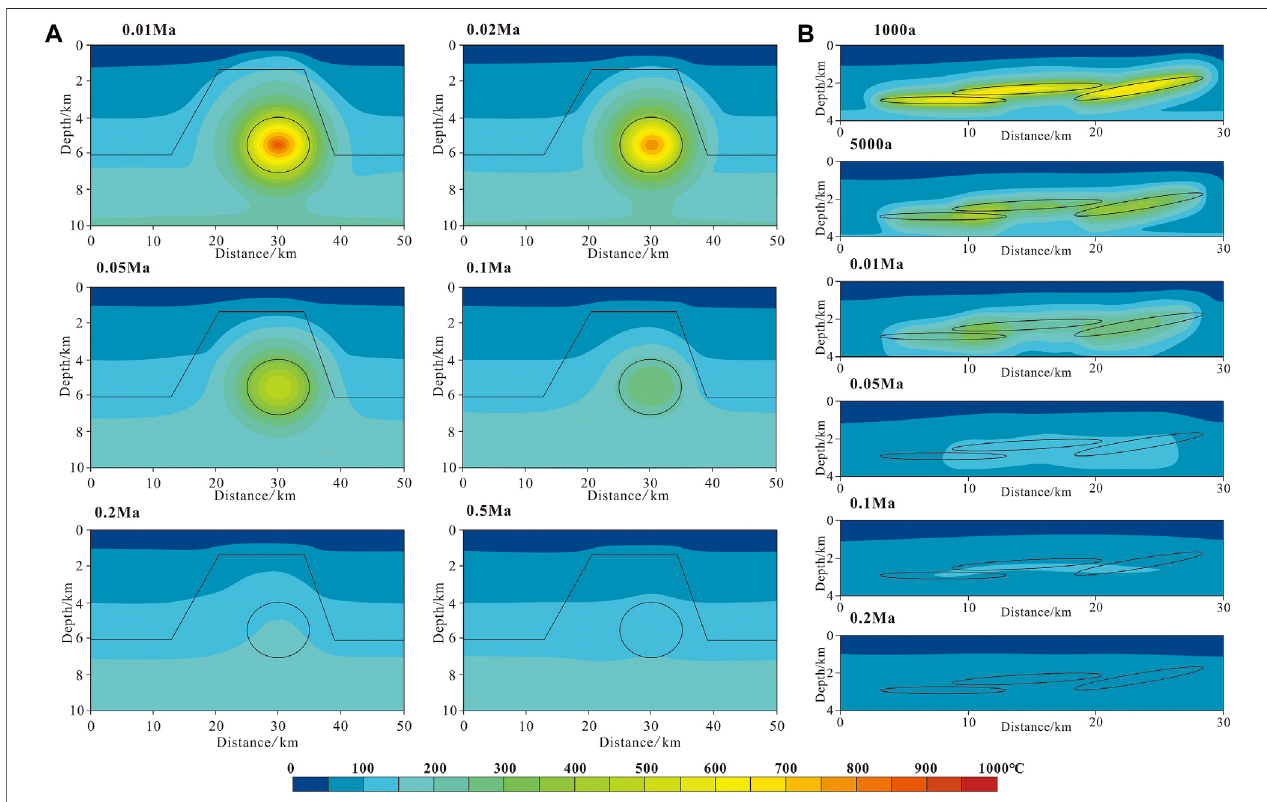
depth distribution of Wells C5 and S401 were drawn ( Figure 10 ). The locations of these two wells are shown in Figure 1 . It can be seen that after the intrusion of the igneous rock, a peak of Ro appears, which shows that after